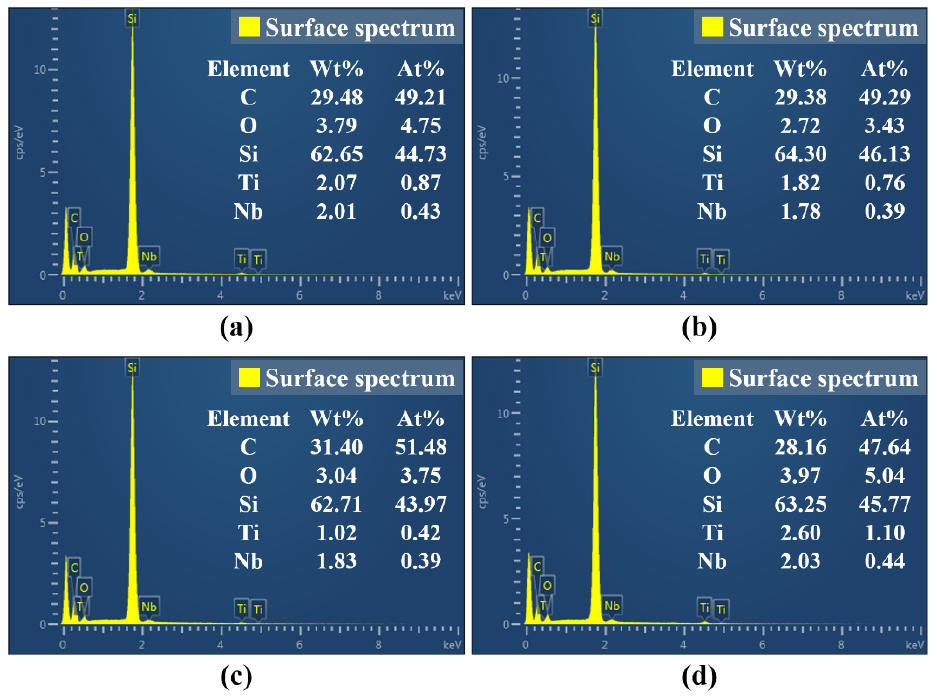
Figure 16. The elemental content of polished surfaces under different defocus amounts. ( a ) − 1 mm, ( b ) 0 mm, ( c ) 2 mm, ( d ) 3 mm. (Figures ( a ), ( b ), ( c ) and ( d ) in Figure 16 are the surface spectrum of